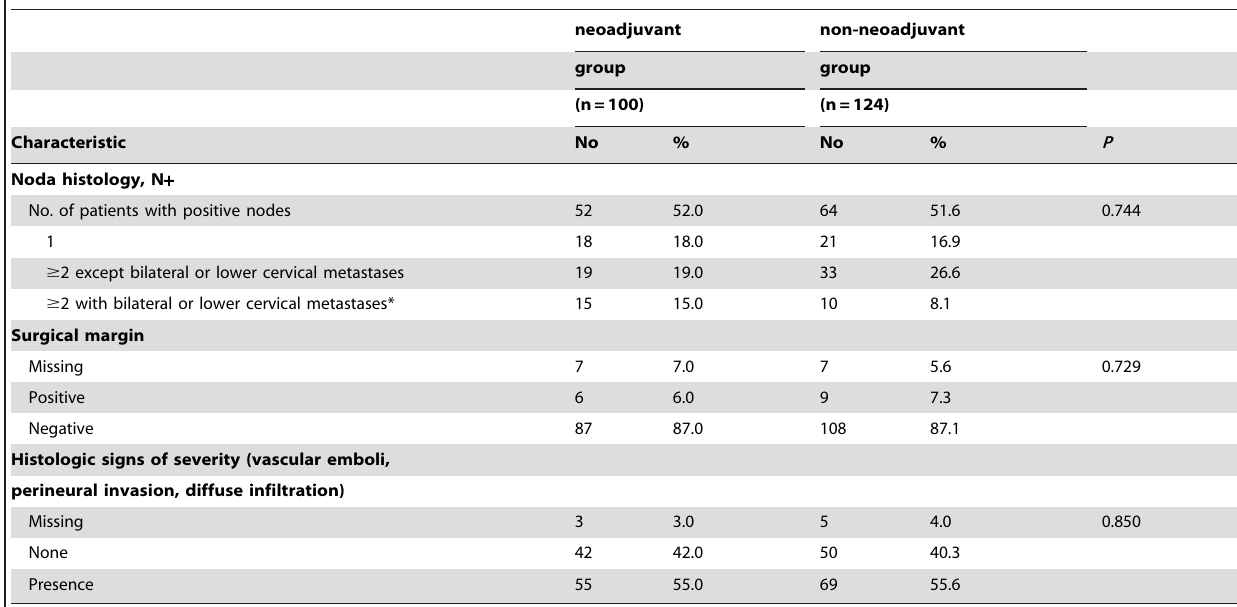
Table 2. Characteristics of surgical specimens.